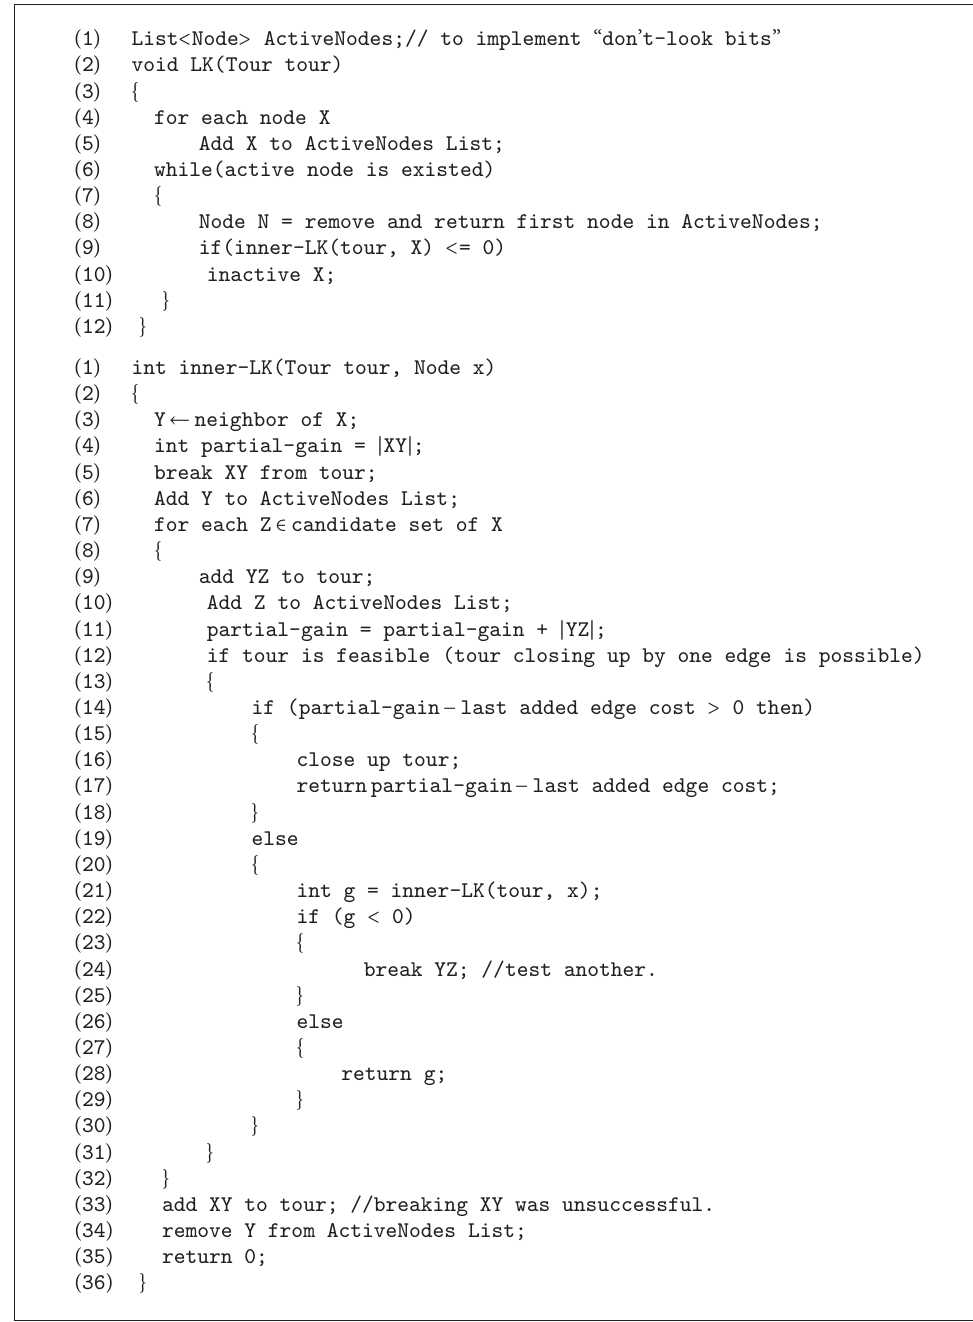
Algorithm 7: Abstract pseudocodes for